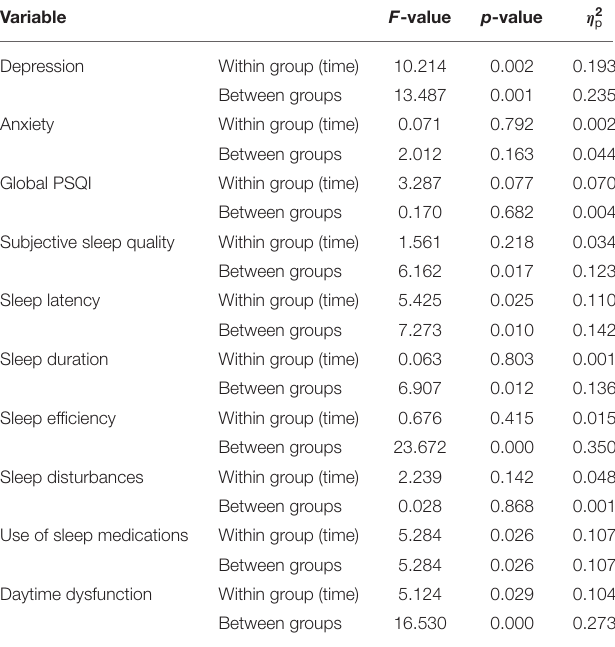
TABLE 5 | ANOVA repeated measures of each dependent variable at post-test.